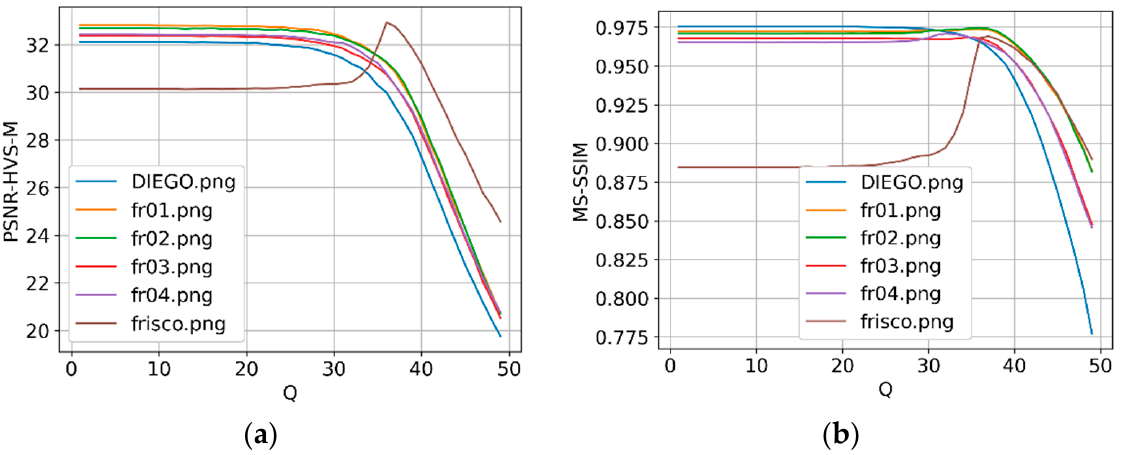
Figure 17. Dependences PSNR − HVS − M tc ( Q ) ( a ) and MS − SSIM tc ( Q ) ( b ) for six test images corrupted by Poisson